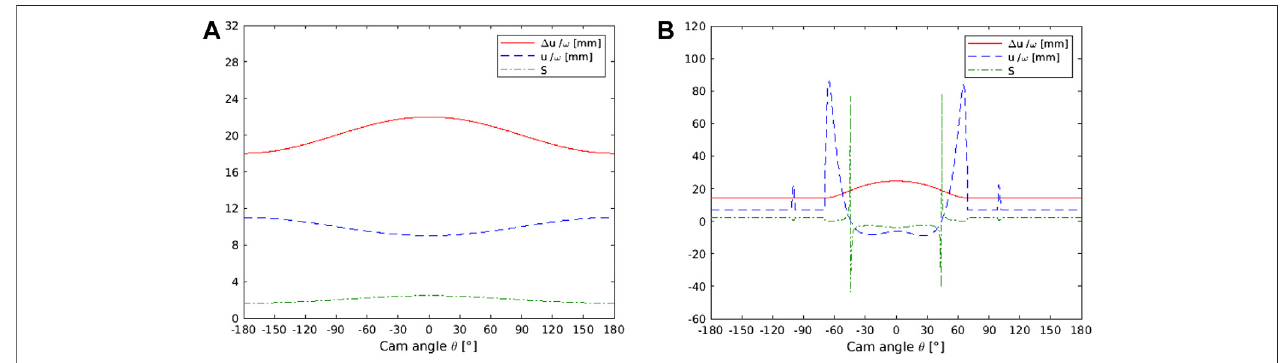
(A) Circular eccentric cam. (B)